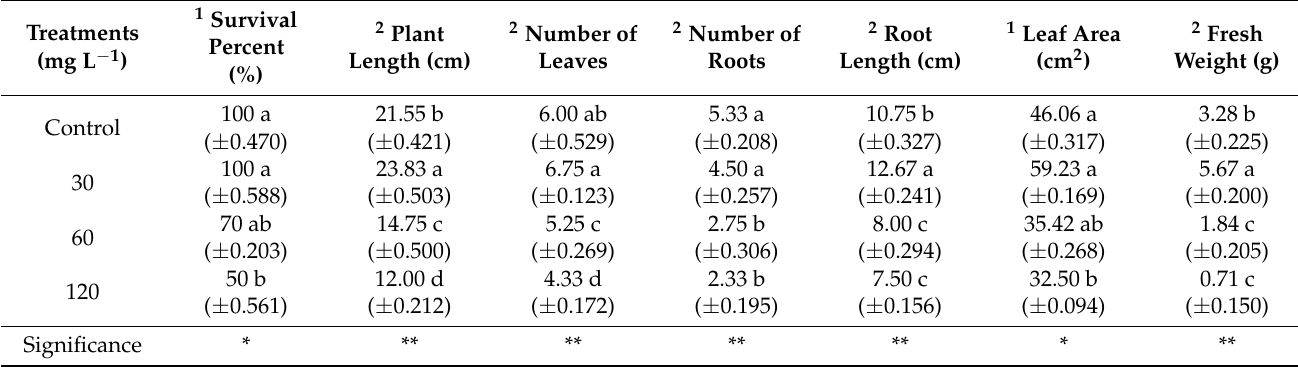
Table 3. Effect of different concentrations of copper sulphate added in multiplication and rooting stages on survival and growth parameters of banana plant after 4 weeks of acclimatization.